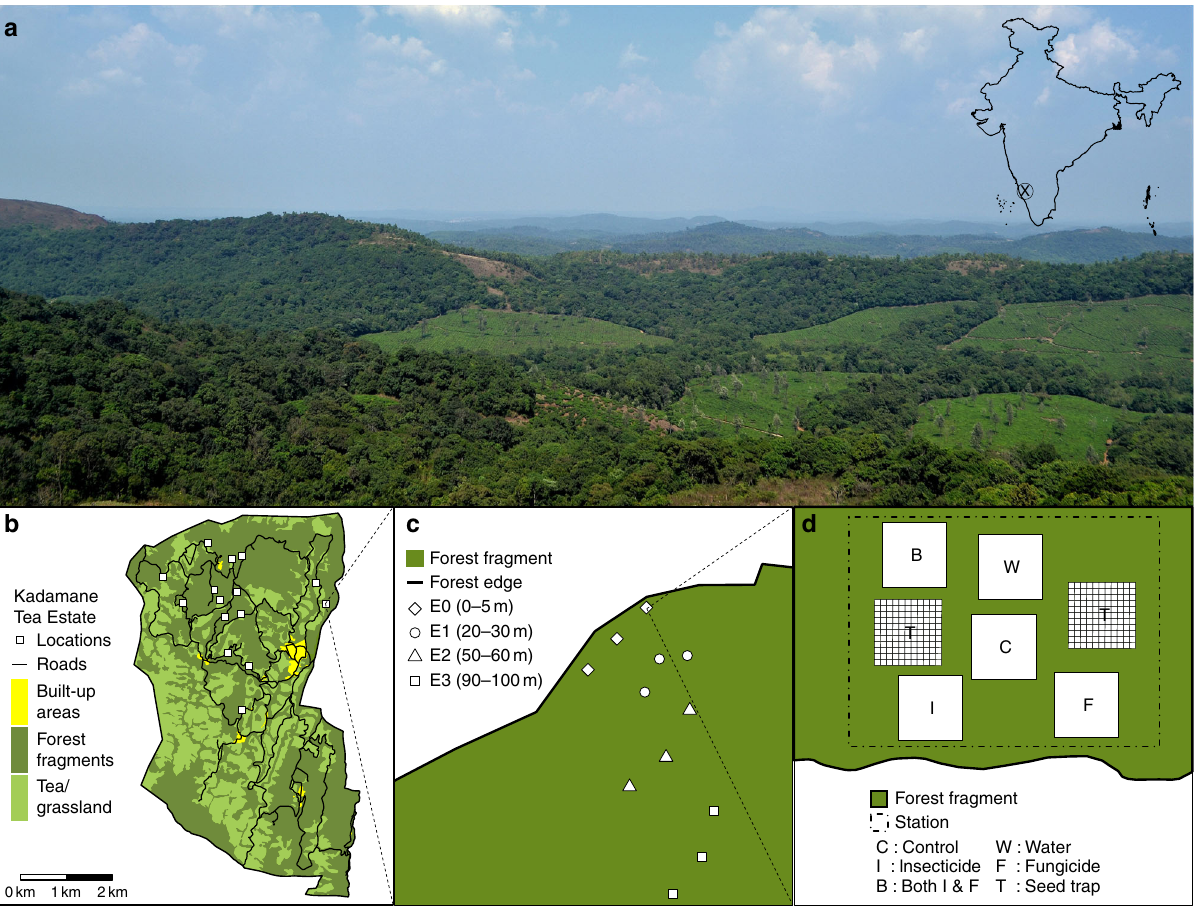
Fig. 1 Study landscape and sampling design. a The research site in the Western Ghats Biodiversity Hotspot in southwest India (inset): a matrix of forest fragments interspersed with tea plantations and roads. b Map of study area and sampled locations. c Experimental design to test how edge-effects modi fi ed plant – enemy interactions and associated diversity of seedlings. Groups of sampling stations were placed at the following distance categories from the forest edge: E0 = 0 – 5 m, E1 = 20 – 30 m, E2 = 50 – 60 m, and E3 = 90 – 100 m. d Each station was comprised of two seed traps and fi ve seedling plots: two control plots (C, W) and one each treated with either insecticide (I), fungicide (F), or both pesticides